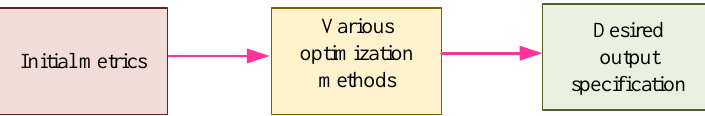
Figure 16. Aim of the optimization process.